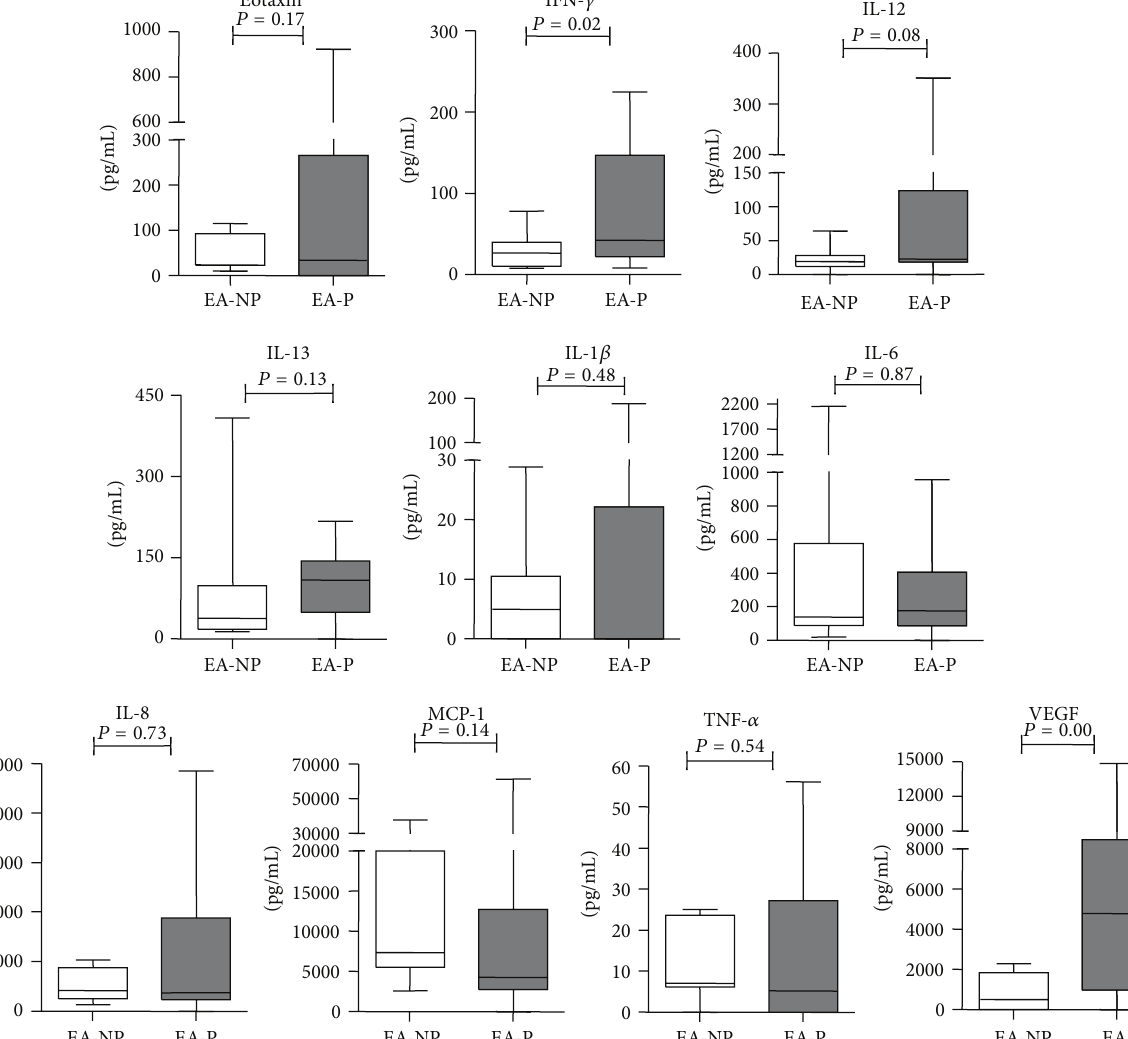
Figure2:ConcentrationsofsolublemediatorsinaspiratesofendometrialsecretionsintheEI-NPandEI-Pgroups.Theexpressionofcytokine profiles [eotaxin, IFN- 𝛾 , IL-1 𝛽 , IL-6, IL-8, IL-12 (p70), IL-13, TNF- 𝛼 , MCP-1, and VEGF] in endometrial secretions obtained before ET from 38 patients (EI-NP: 14; EI-P: 24) was analyzed. The box plot horizontal lines represented the median and the 25th–75th percentiles. The 𝑃 values obtained are the results of the Mann-Whitney 𝑈